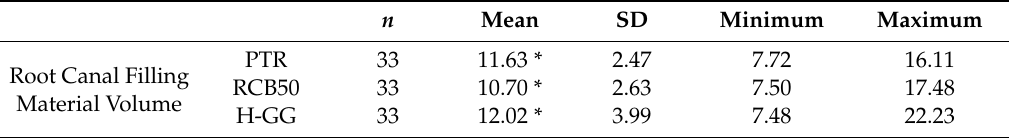
Table 1. Descriptive analysis of carrier-based root canal filling material volume (mm 3 ), regarding the non-surgical endodontic retreatment study groups.